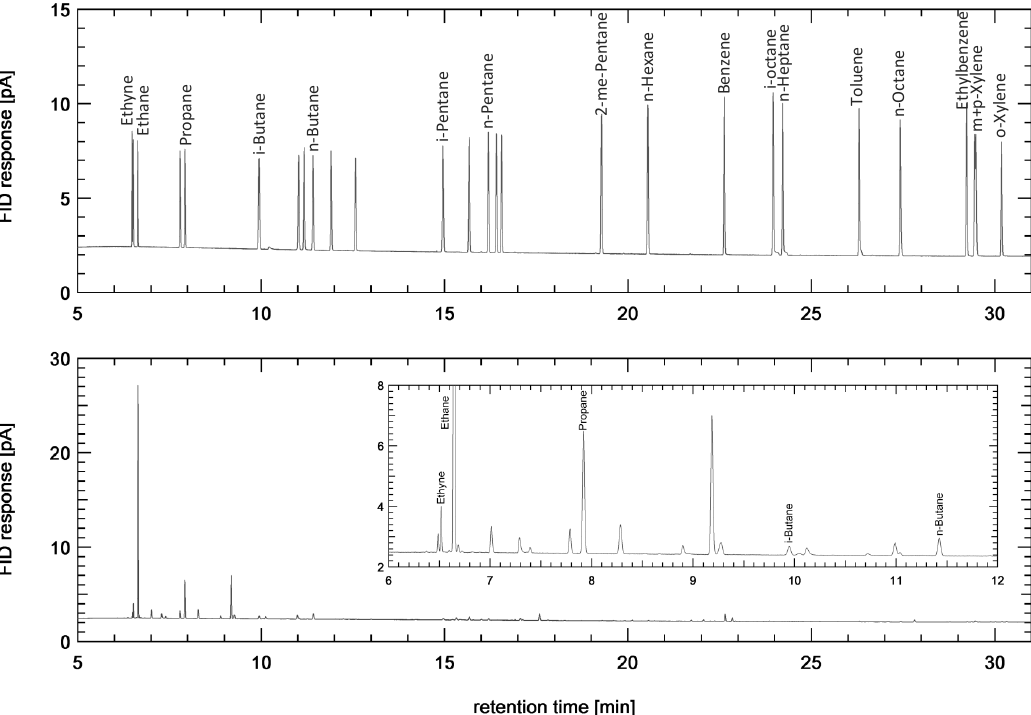
Fig. 2. Chromatograms from analysis of the primary standard (top) and of a sample collected in the upper troposphere (bottom). Peaks analyzed for CARIBIC samples are labeled in the primary standard chromatogram; peaks not considered (e.g. alkenes, halocarbons) are